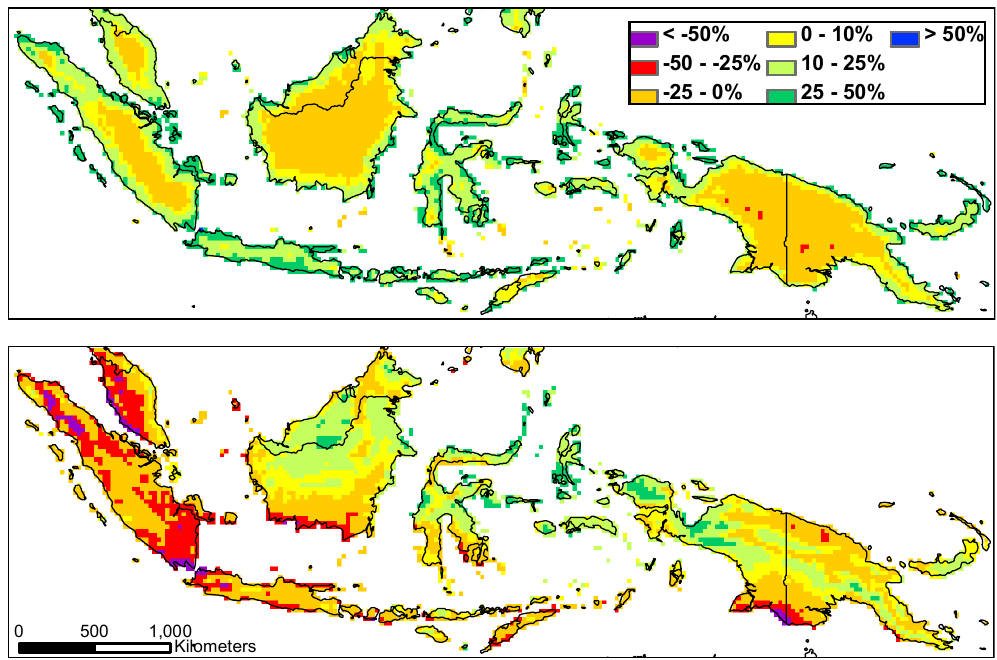
Fig. 5. Relative difference in annual average rainfall over the period 2003–2008 between TMPA 3B42RT and CMORPH (top panel) and TMPA 3B42RT and PERSIANN (lower